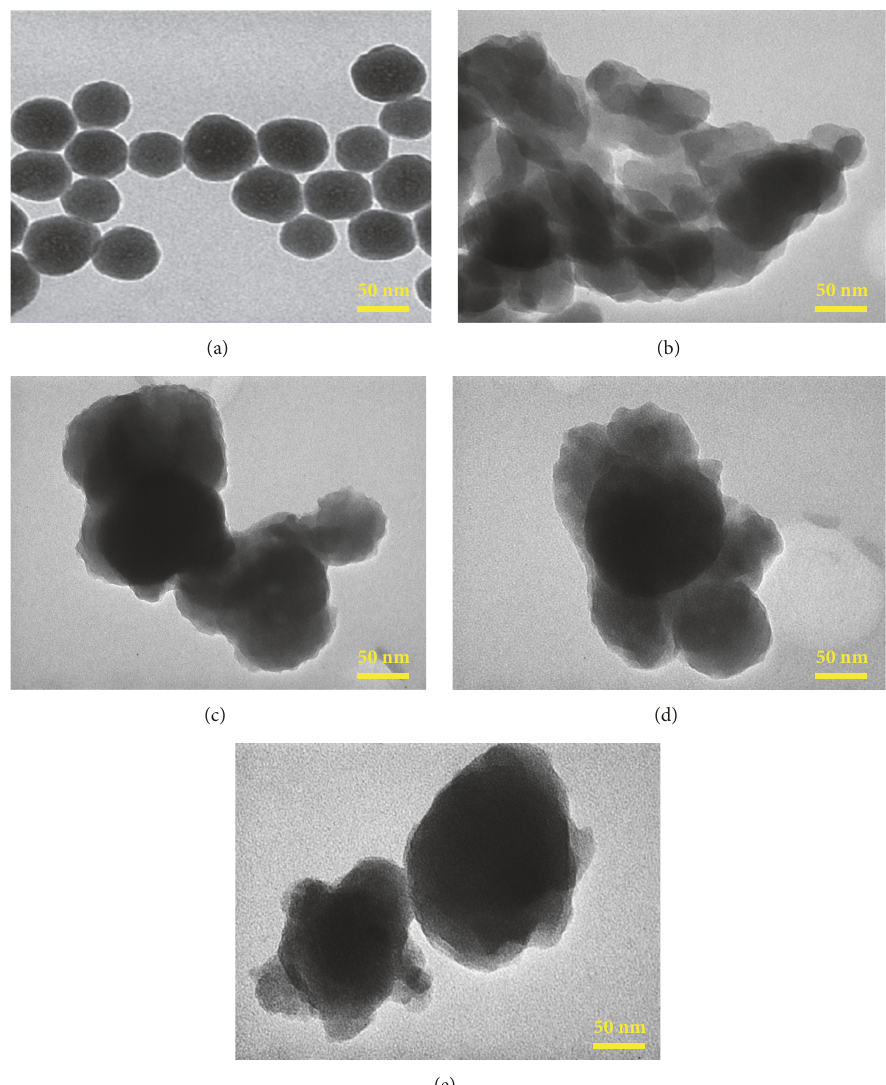
Figure 5: TEM images of (a) SiO 2 (b) SiO 2 /PPy, (c) SPO1, (d) SPO2, (e)